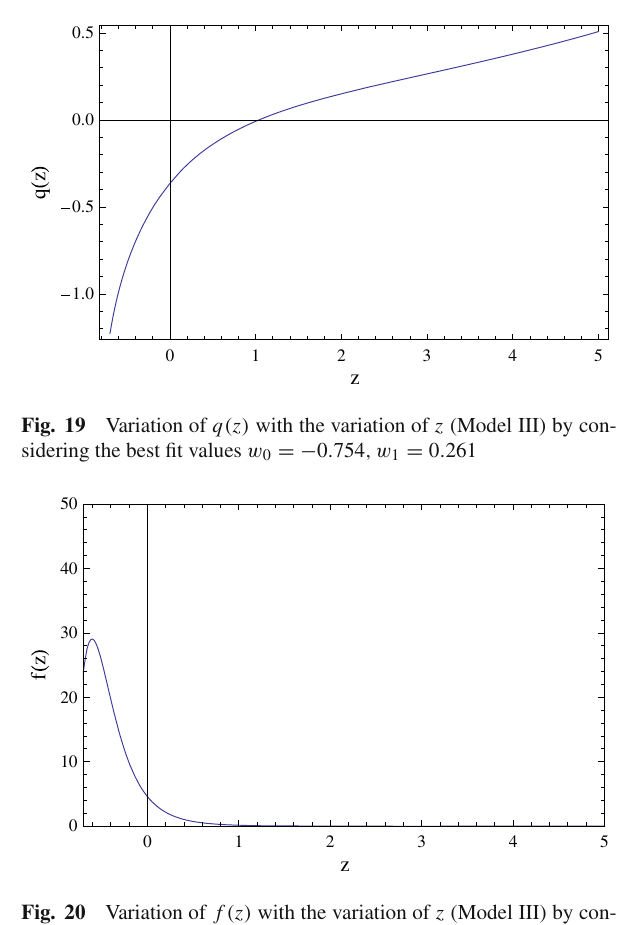
Fig. 20 Variation of f ( z ) with the variation of z (Model III) by con- sidering the best fit values w 0 = − 0 . 754 ,w 1 = 0 . 261